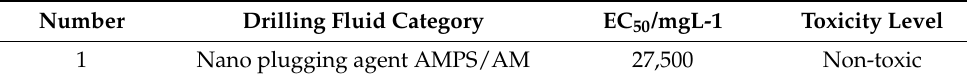
Table 2. Biotoxicity test results of nano blocker AMPS/AM. Number Drilling Fluid Category EC 50 /mgL-1 Toxicity Level 1 Nano plugging agent AMPS/AM 27,500